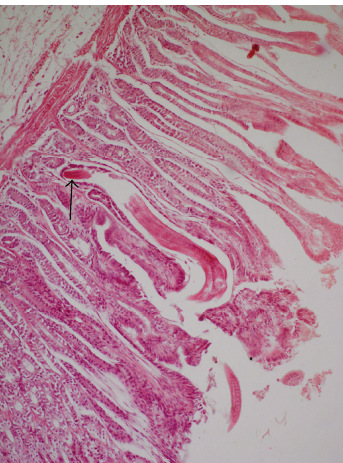
Figure 4: Higher magnification of Figure 3 showing more con- spicuous eosinophils, macrophages, and a few fibroblasts among inflammatory cells (H. E. original magnification × 400X).